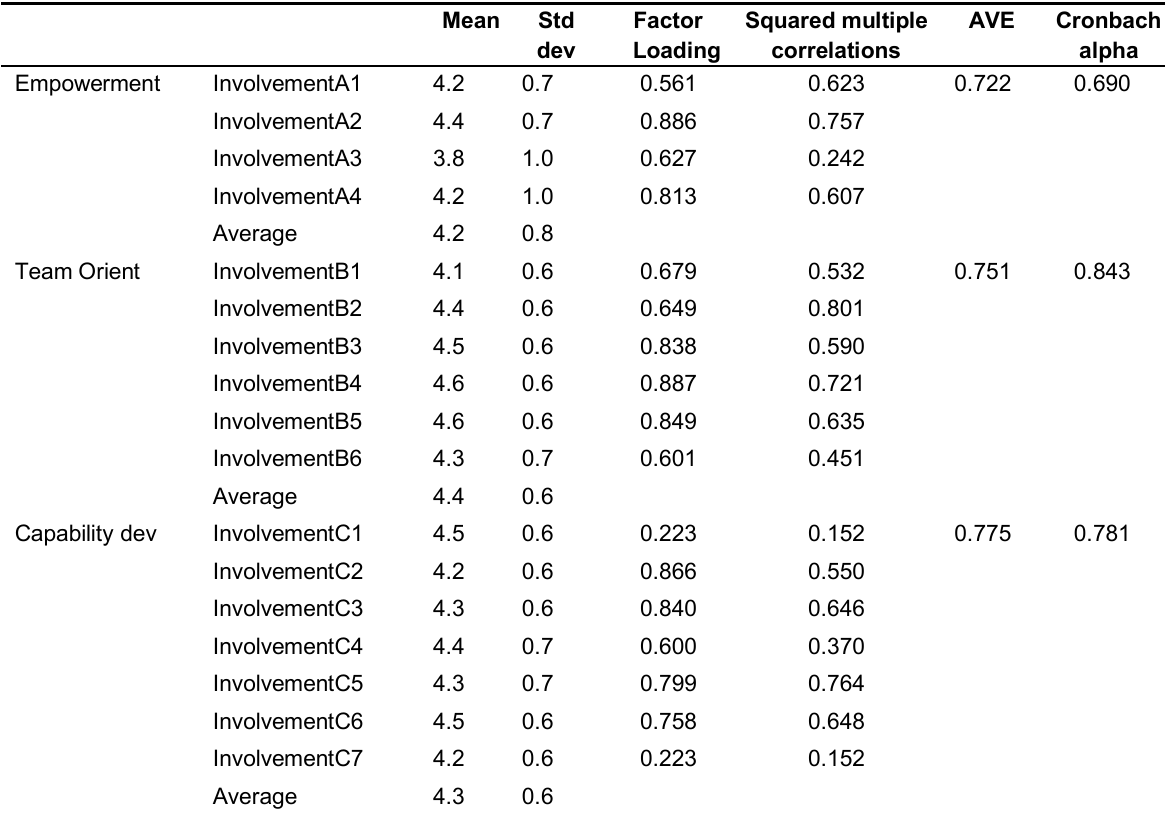
Table 2: Validity of Involvement Measurements Summary